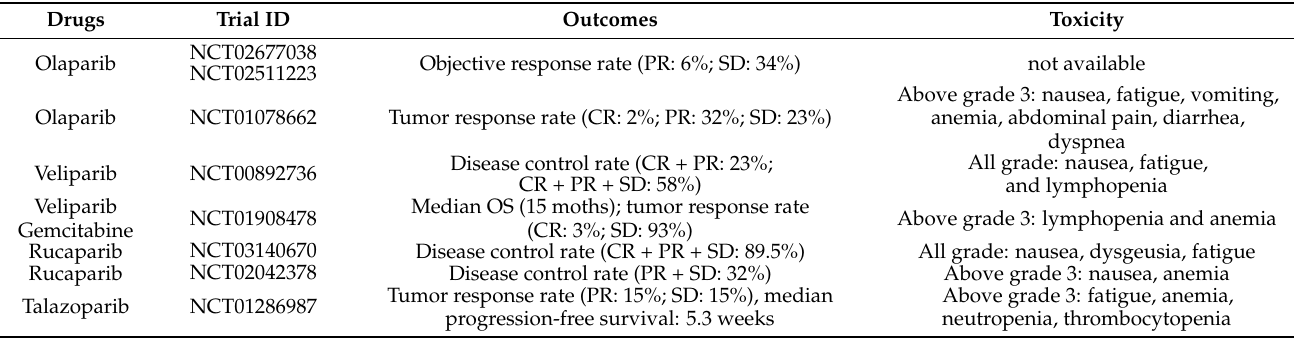
Table 1. Clinical trials of PARP-1 inhibitor for the treatment of pancreatic